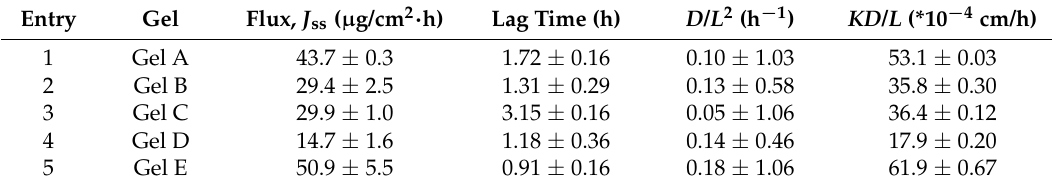
Table 2. The skin permeation parameters of PS gel (gel A–D) and toluene gel (gel E).